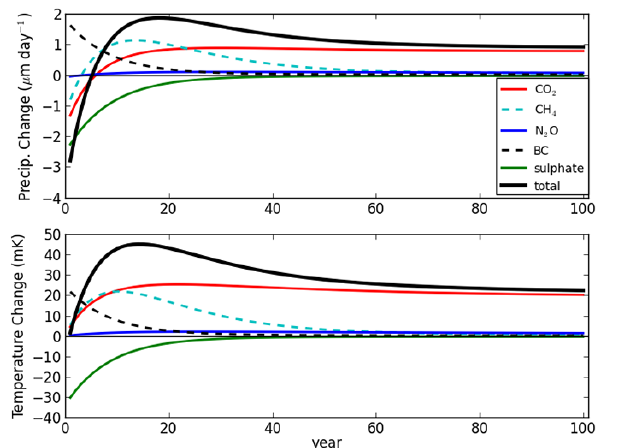
Figure 7. Precipitation change, in µmday − 1 (top panel), and tem- perature change, in mK, (bottom panel) in the years after 2008, fol- lowing a pulse emission in 2008, calculated using the AGPP P and AGTP P and using estimated emissions of the species in 2008.